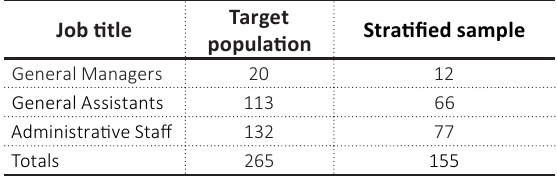
Table 1. Target population and sample